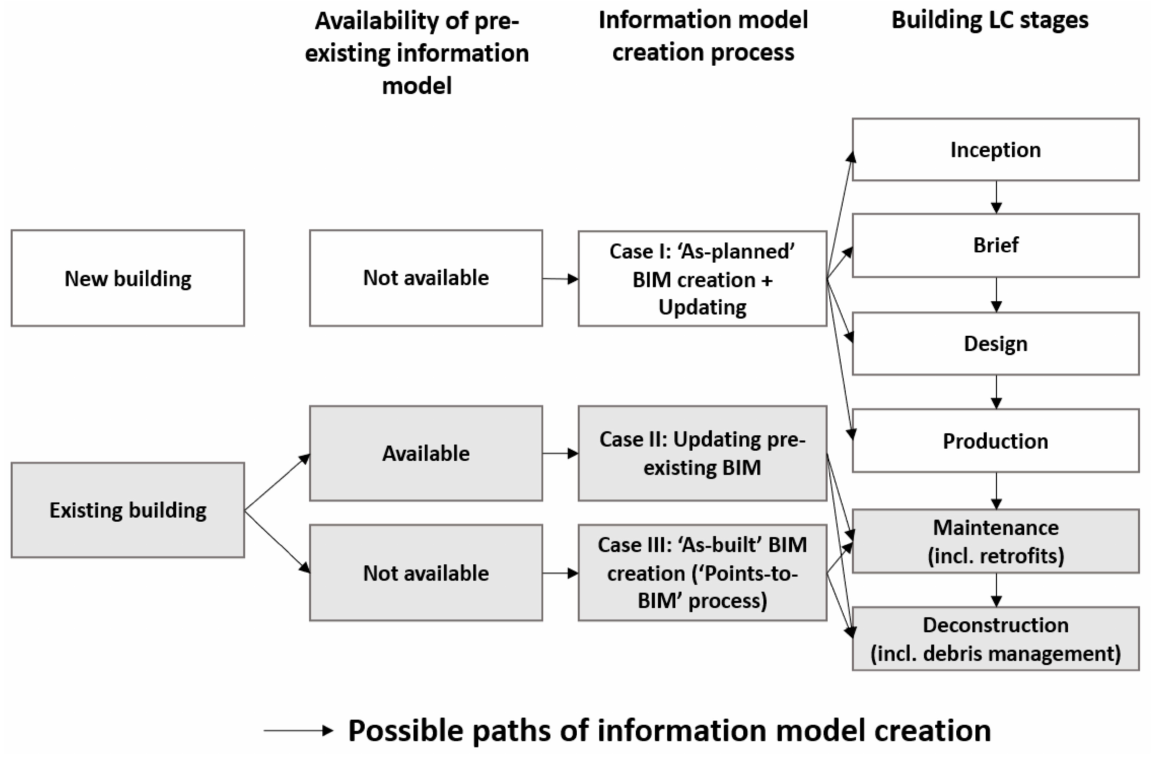
Figure 8. Information model creation processes in new or existing buildings depending on available, pre-existing models and their relationship with lifecycle (LC) stages